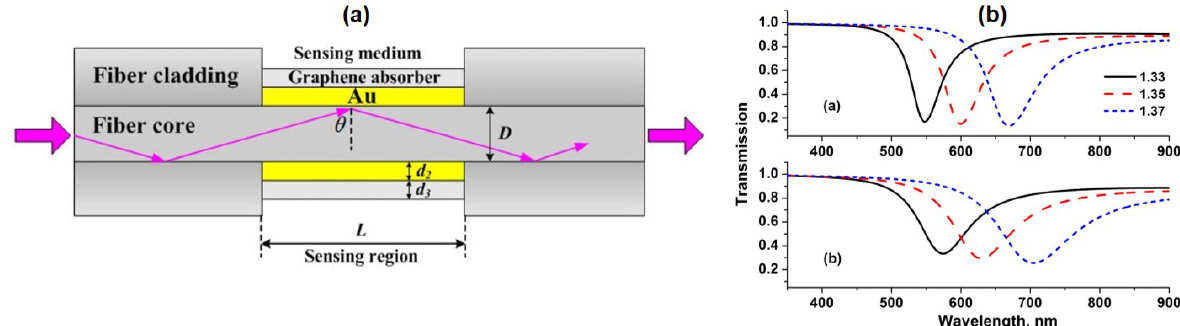
Figure 11. ( a ) Experimental scheme of the SPR biosensor coupled with fiber optic. ( b ) SPR spectrum at the refractive index of 1.33, 1.35, and 1.37 (top: without graphene, bottom: with graphene) (adapted with permission from Reference [57], copyright